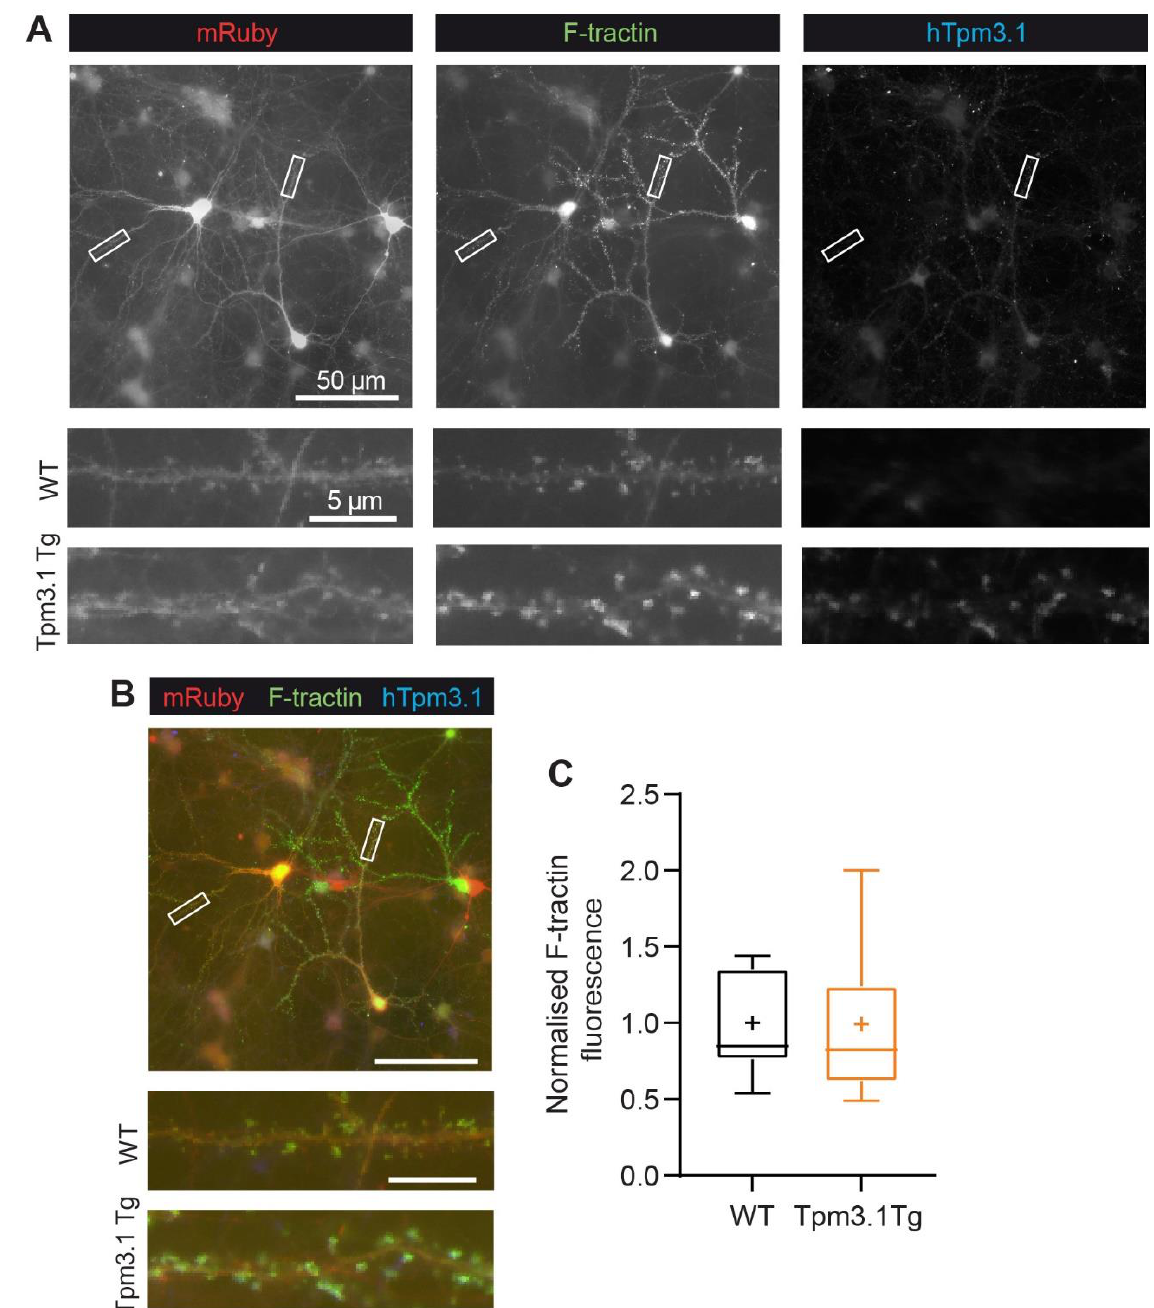
Figure 3. F-tractin measurement in dendritic spines. ( A ) Representative images of individual hTpm3.1, F-tractin, and mRuby channels and ( B ) merged image. ( C ) F-tractin fluorescence, WT n = 14, hTpm3.1 Tg n = 13 cells from 3 culture preparations. WT values are shown in black, Tpm3.1 Tg values shown in orange. Scale bars indicate 50 µm (top) and 5 µm.